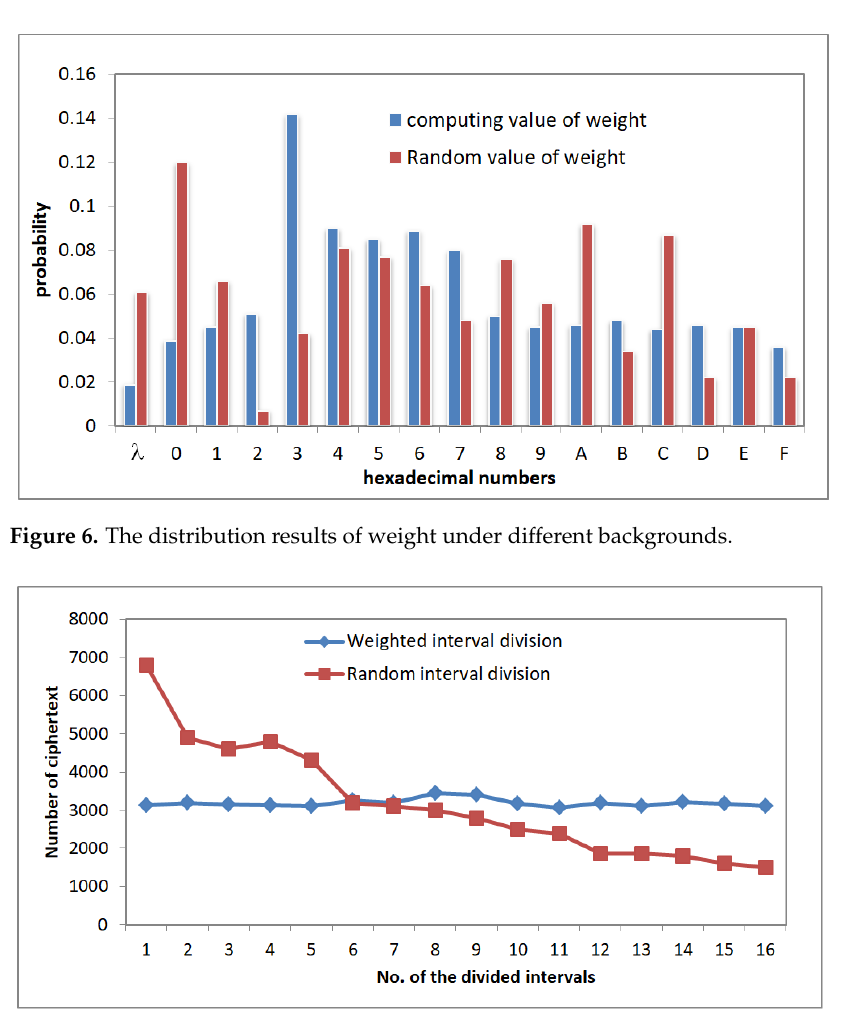
Figure 7. Total number of the ciphertext in weighted interval and random interval.